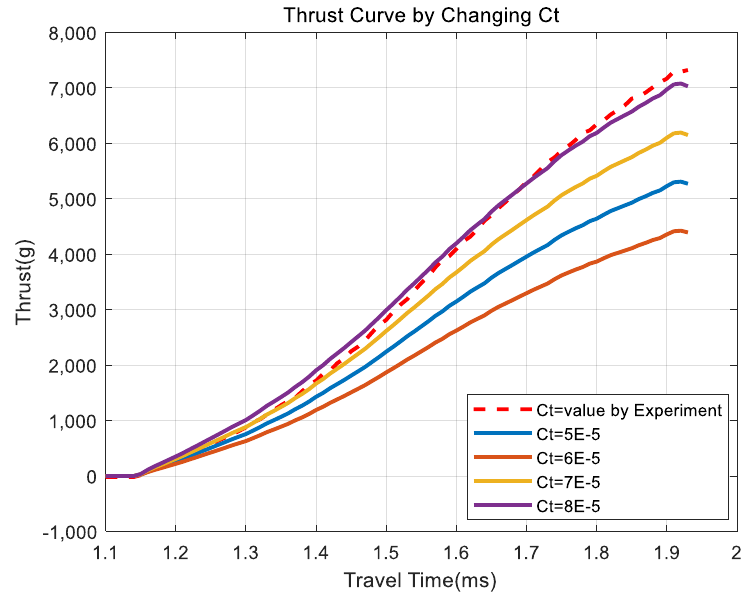
Figure 16. Result of thrust by changing 𝑐 𝑇 .